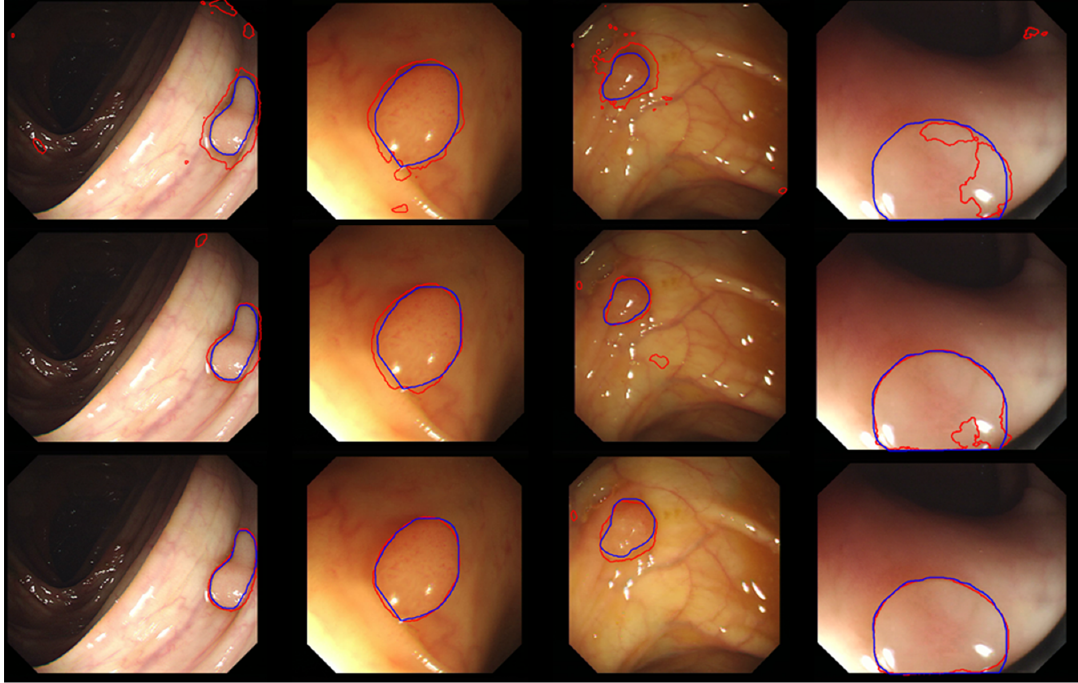
Figure 15. A sample of typical results for the FCN8s (the first row), ResFCN (the second row), and Dilated ResFCN (the last row) with the ground truth represented by the blue contour and the segmentation by the red contour.